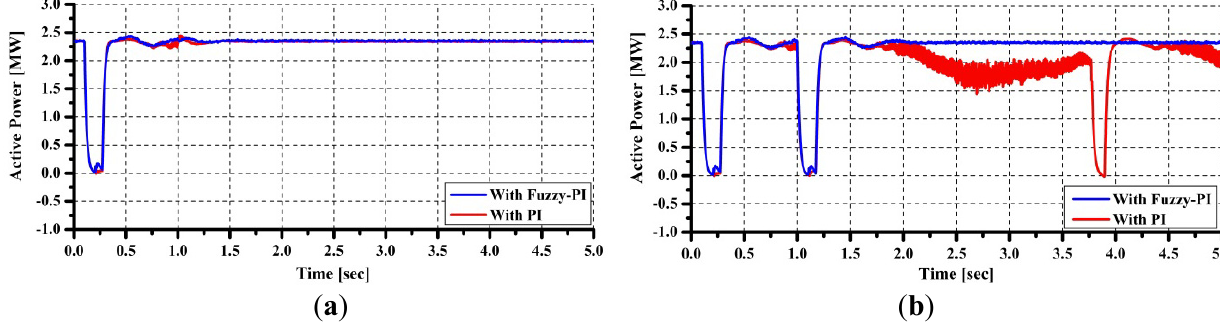
Figure 26. Active power output of IG. ( a ) case 1; ( b ) Case